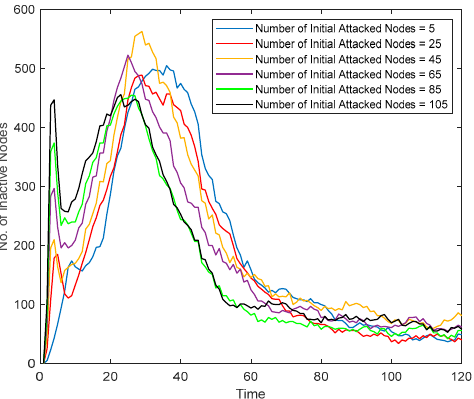
Figure 5. The number of inactive nodes as a function of time under load-based failures with a various number of initially attacked nodes. In all cases, α = 1, P = 0.01, T = 0.05, RP = 0.8.